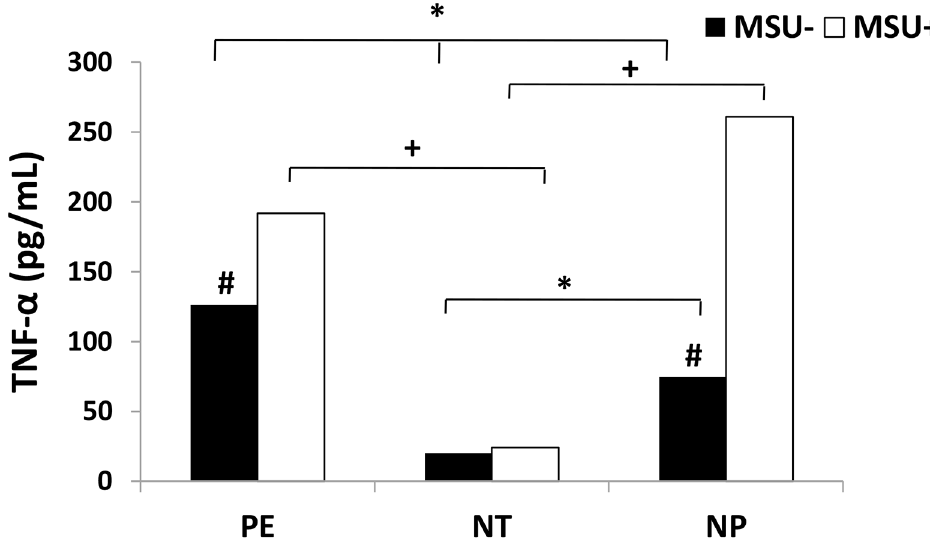
Fig 4. IL-1 β (A) and IL-18 (B) production by monocytes. Monocytes from pregnant women with preeclampsia (PE), normotensive pregnant women (NT) and non-pregnant women (NP), were cultured in the presence (MSU + ) or absence (MSU - ) of monosodium urate. Results are shown as median. * P < 0 . 05 shows significant difference between MSU - groups; + P < 0 . 05 shows significant difference between MSU + groups; # P < 0 . 05 vs MSU + .